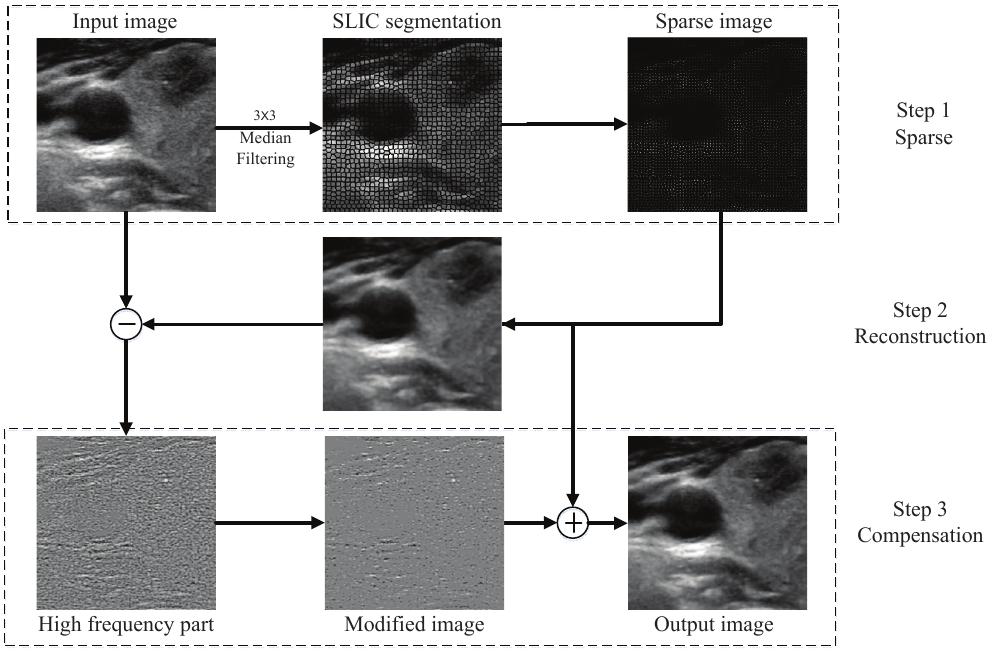
Figure 1. Flowchart of the proposed